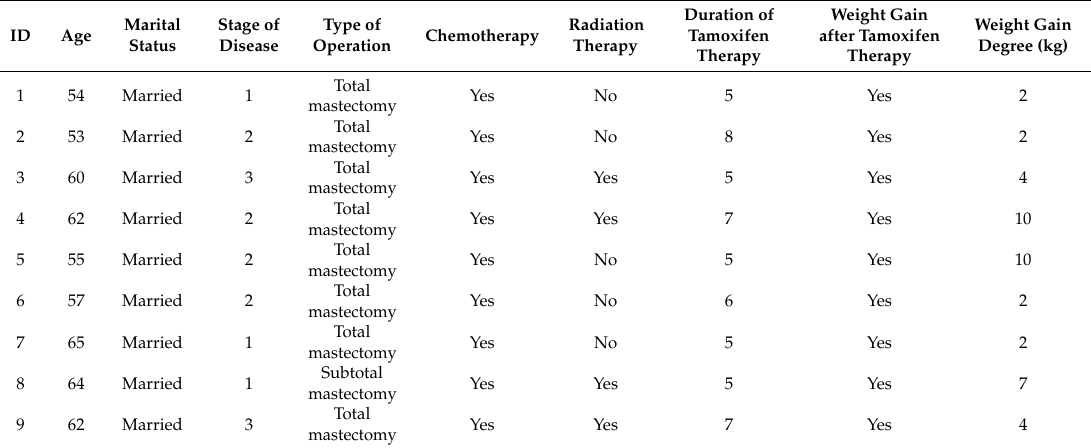
Table 1. General characteristics of participants.